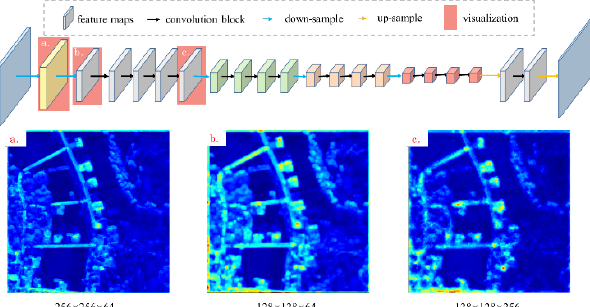
Figure 6. Similar visualizations of feature maps ( a, b, c ) in ResNet , the input image is the same as Fig. 2.